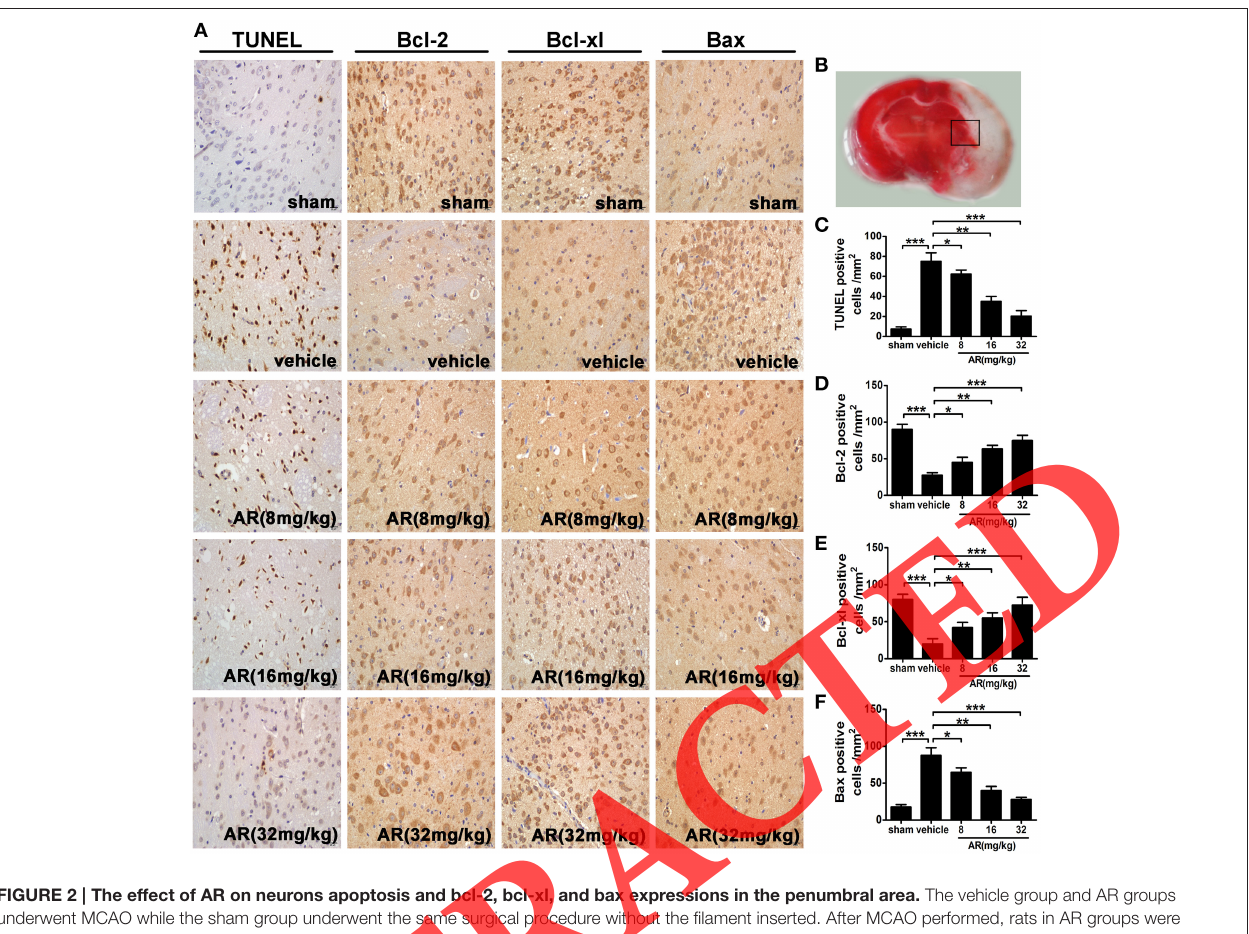
FIGURE 2 | The effect of AR on neurons apoptosis and bcl-2, bcl-xl, and bax expressions in the penumbral area. The vehicle group and AR groups underwent MCAO while the sham group underwent the same surgical procedure without the filament inserted. After MCAO performed, rats in AR groups were intraperitoneally administrated with AR (8, 16, and 32mg/kg) for 3 days. (A) Representative photographs of TUNEL staining, immunohistochemical staining of bcl-2, bcl-xl, and bax in the cortex of MCAO rat. (B) The black square indicates the penumbral area. (C) TUNEL staining was analyzed by Image Pro Plus, and each datum was presented as TUNEL positive cells numbers in per mm 2 within five random independent view fields. Quantification of the levels of bcl-2 (D) , bcl-xl (E) , and bax (F) expressions was presented as immunohistochemical positive cells numbers in per mm 2 within five random independent view fields. The values were presented as mean ± SD ( n = 8 ). * P < 0.05 ; ** P < 0.01 ; *** P < 0.001